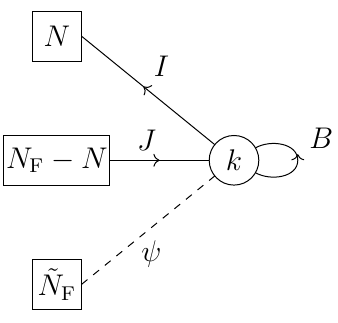
Figure 1 . = (0 ; 2) quiver gauge theory: it has 1 U( k ) vector multiplet, I , J and B chiral multiplets N and Fermi multiplet. It describes the moduli space of vortices of 4d, with N F fundamental chirals and ~ N F antifundamental chirals.